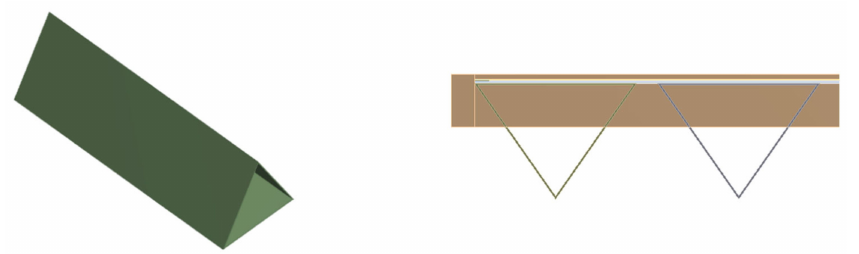
Figure 6. Geometry studied in the